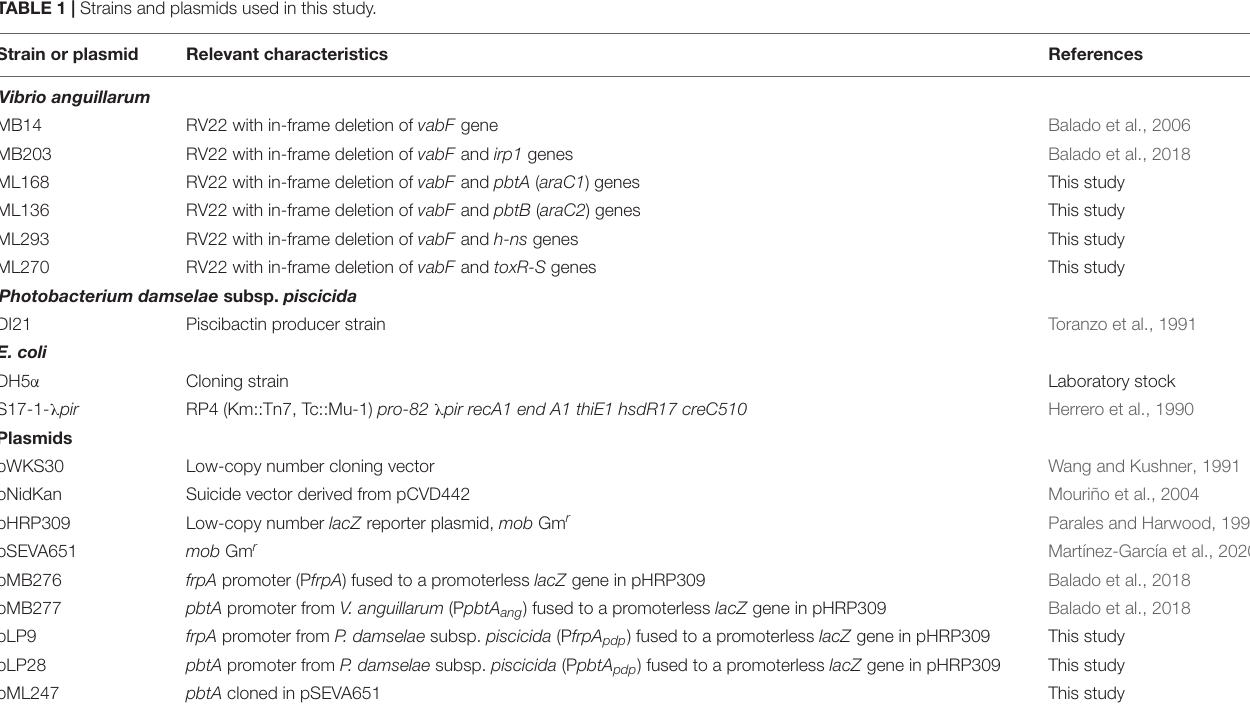
FIGURE 1 | V. anguillarum piscibactin operon contained within the irp -HPI genomic island. TABLE 1 | Strains and plasmids used in this